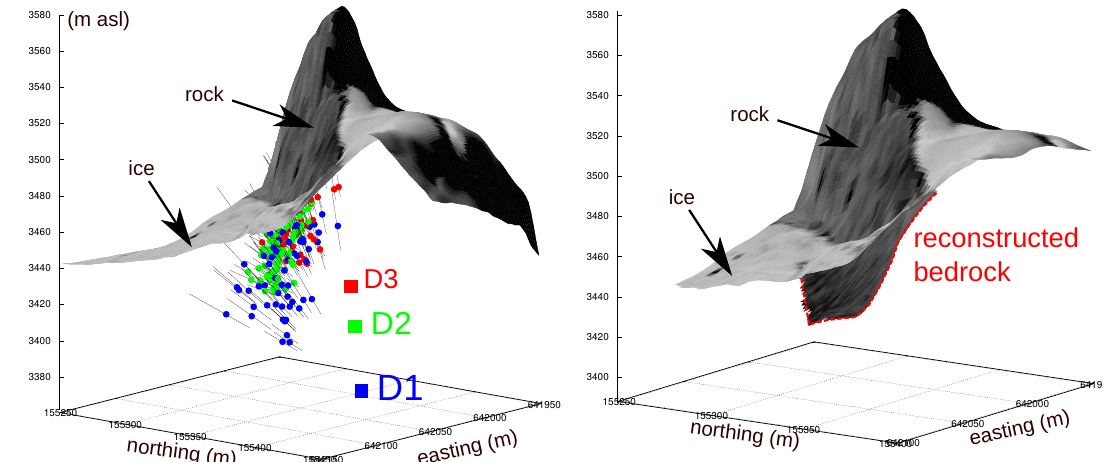
Figure 15. left : three-dimensional representation of ice/bedrock interface determined from each bin of muon flux (D1: blue, D2: green, D3: red). The error bars show the statistical uncertainty (1 σ ). right : reconstructed shape of the bedrock under the glacier. The vertical scale is magnified two